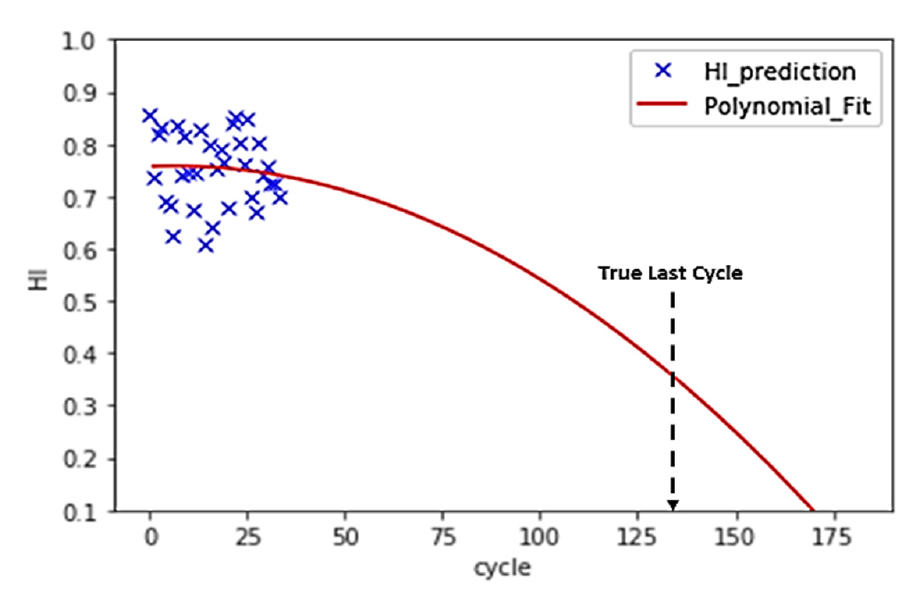
Figure 13. FD001_Test turbo unit 85 (34 cycles) test data